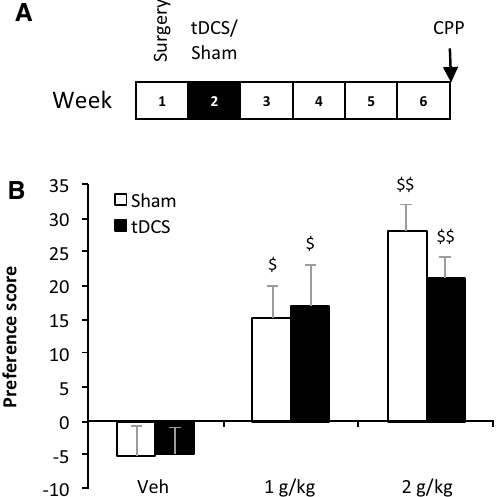
Figure 2. tDCS does not modulate ethanol-induced CPP. ( A ) Experimental design. ( B ) tDCS has no impact on ethanol-induced CPP (stimulation effect: